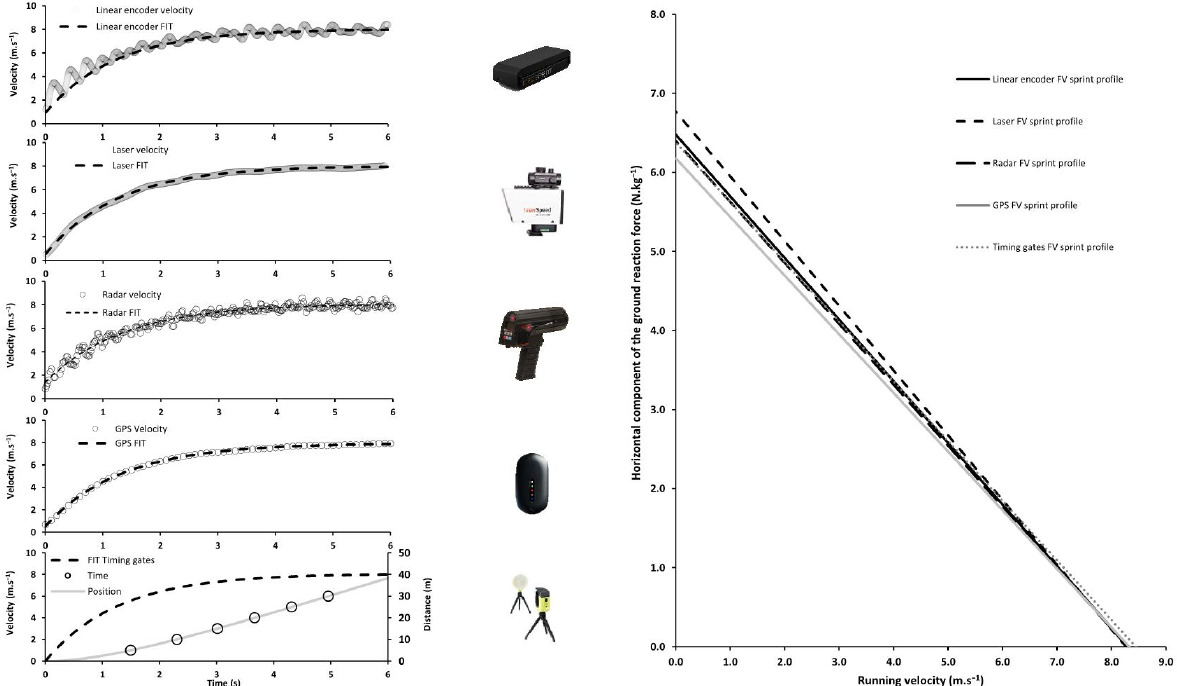
Figure 1. Raw velocity data and raw velocity data fitted by the mono-exponential function [5], and force–velocity profiles for the two best trials were subsequently computed for each system (linear encoder, laser, radar, GPS, and timing gates). The maximal velocity (V max ), acceleration time constant (Tau), theoretical maximal velocity (V 0 ), and horizontal component of the ground reaction force (F 0 ) were calculated.